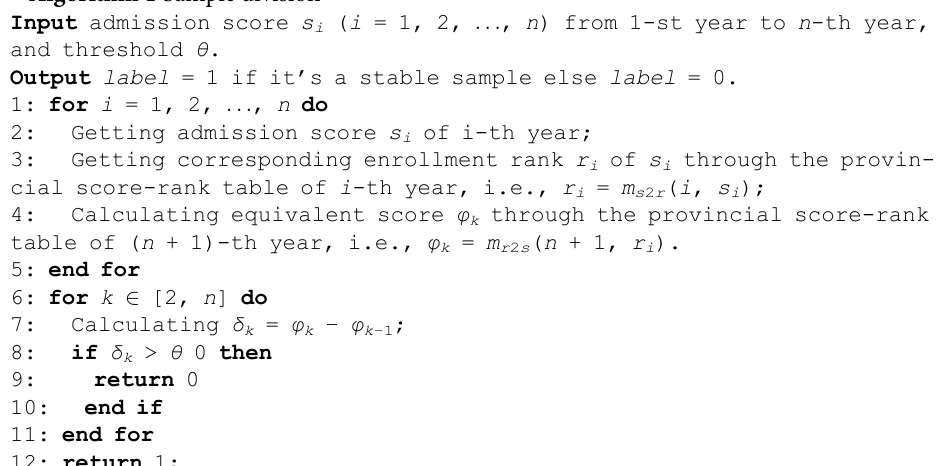
Algorithm 1 Sample division